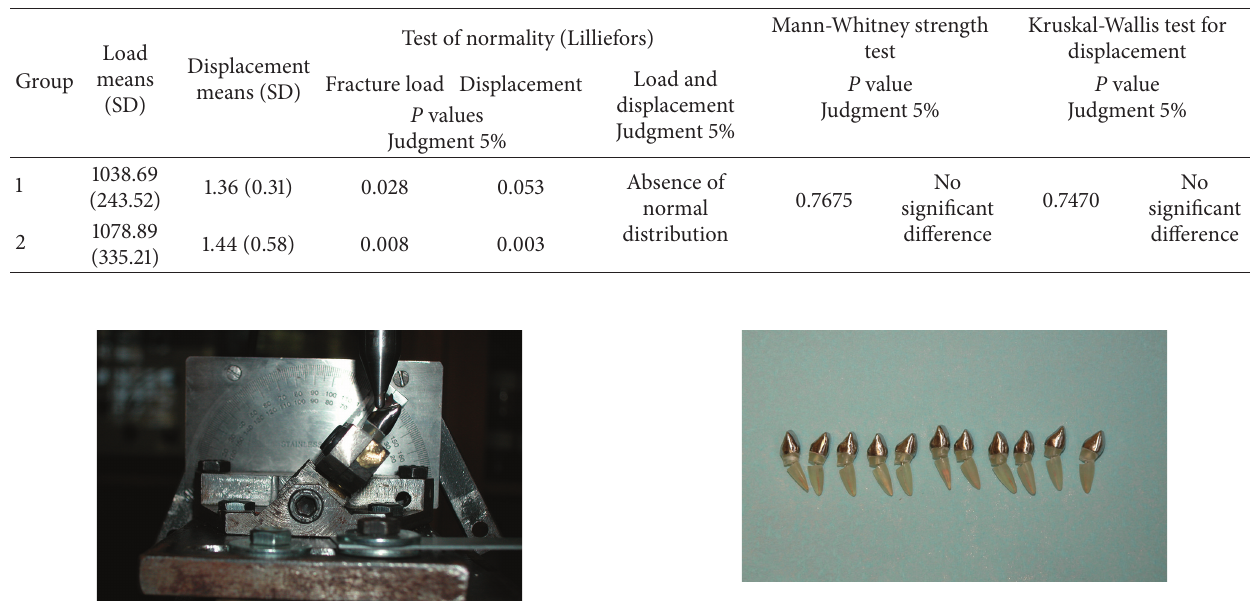
Figure 9: Fracture line visualized after testing in all specimens. line direction and level after fracture testing (Figure